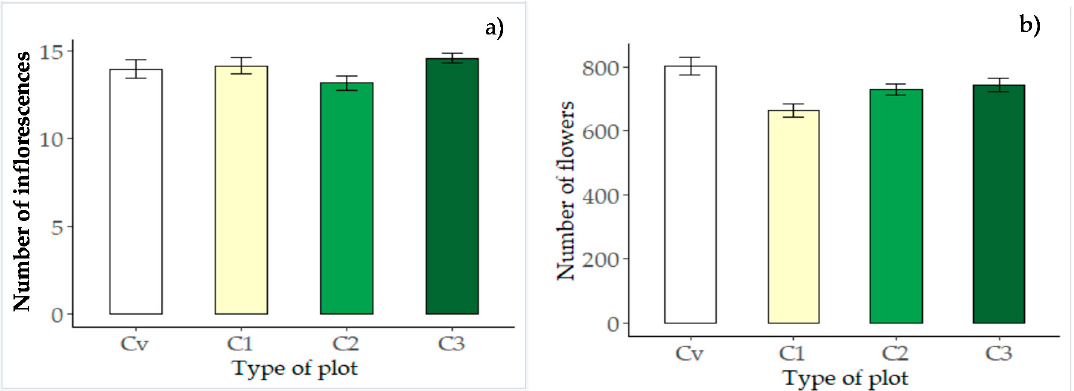
Figure 6. Number of inflorescences per grapevine plant ( a ) and the number of flowers per inflorescence ( b ), counted at flowering in plots in conventional production (Cv) and in their first, second or third year of conversion to organic farming (C1 to C3). Mean ± standard deviation.